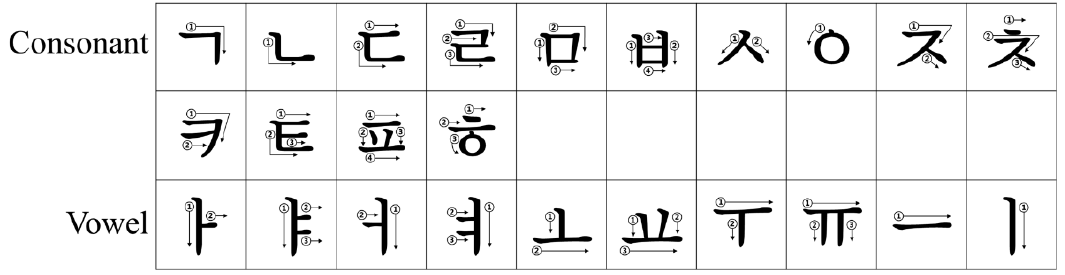
Figure 1. This is the order in which consonants and vowels are written in the elementary school curriculum.